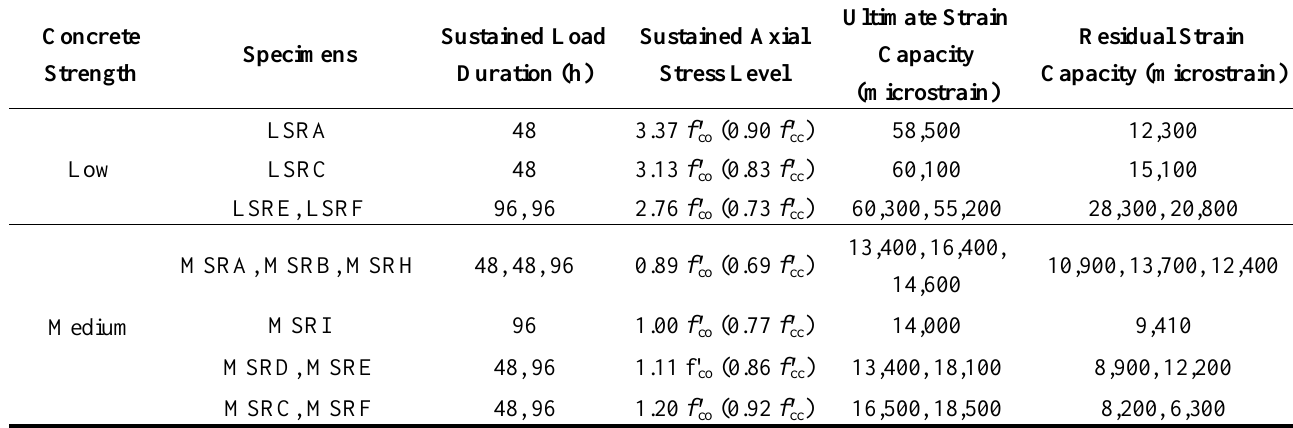
( a ) ( b ) Table 3. Ultimate and residual strain capacities of short-term creep